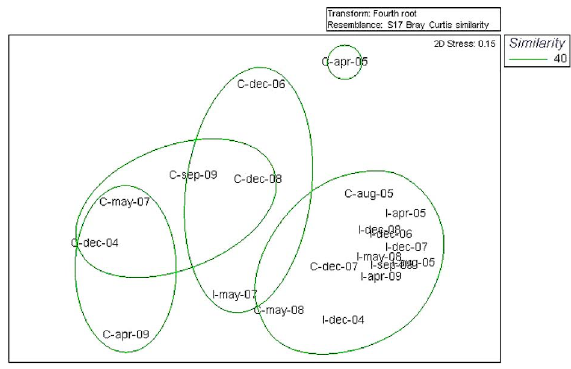
Fig. 2. – n-MDS of sampling campaigns considering months and years. I, impact locations; C, control locations. Circles indicate 40% similarity.